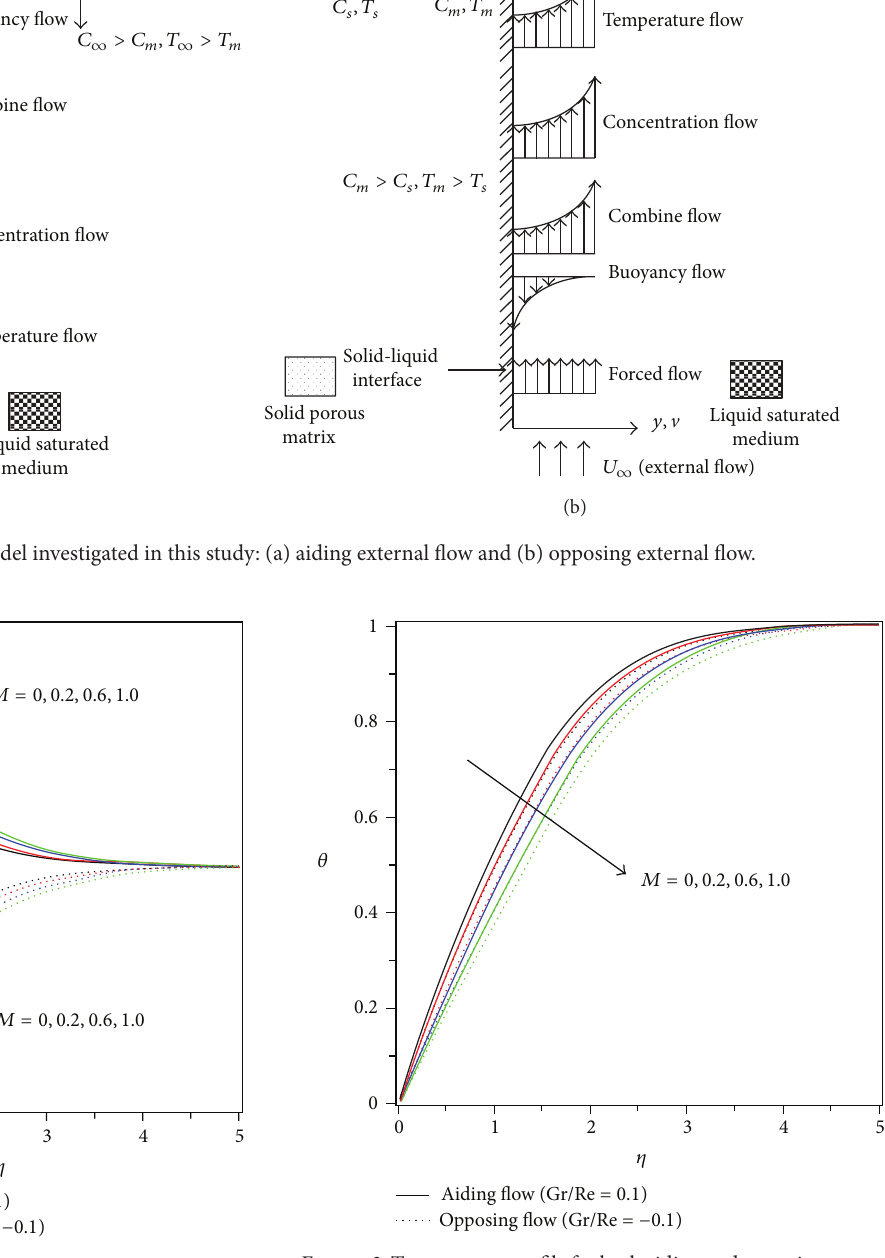
Figure 2: Velocity profile for both aiding and opposing external flows for different values of 𝑀, 𝑁 = 0.5 , Df = 0.02 , Sr = 0.2 , and Le = 1.0 .